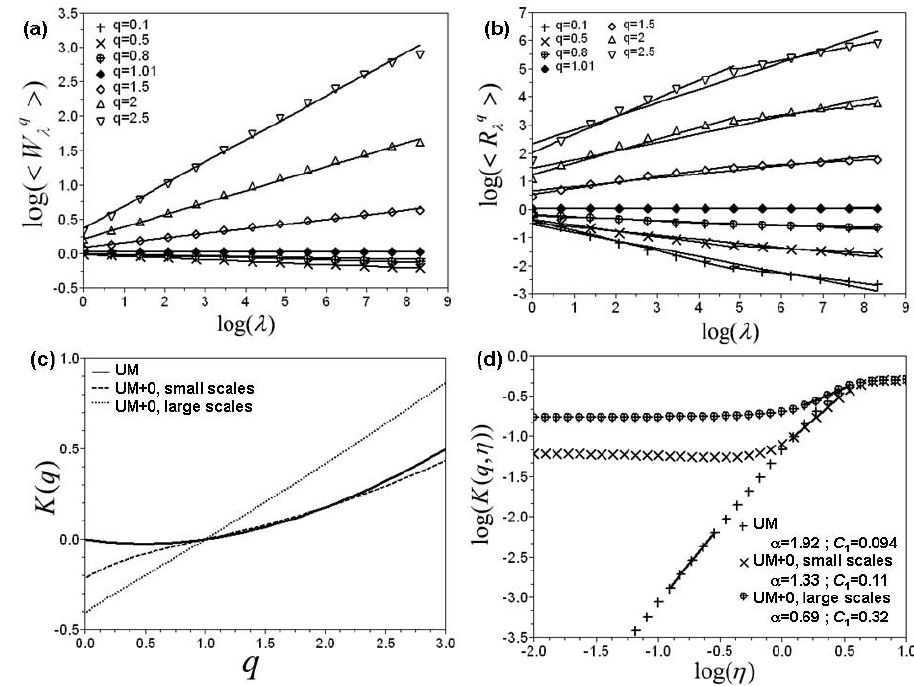
Fig. 3. (a) Scaling of W λ , (Eq. 3 in log-log plot) (b) scaling of R λ , (c) K(q) for R λ , and (d) determination curve of C 1 and α , for simulation parameters C 1 = 0 . 1, α = 1 . 9, γ 0 = 0 . 1 and p 0 = 0 .